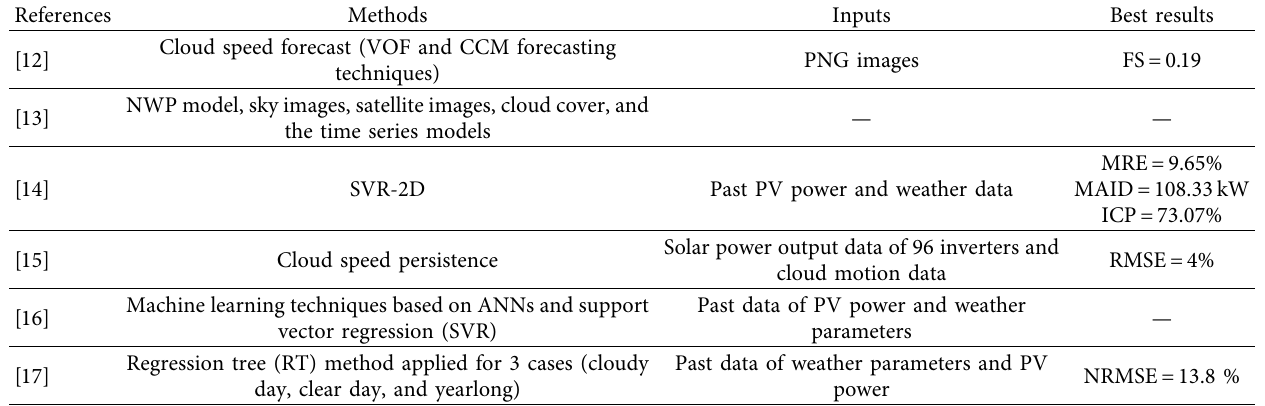
Table 1: Summary of the literature review in the very short-term time